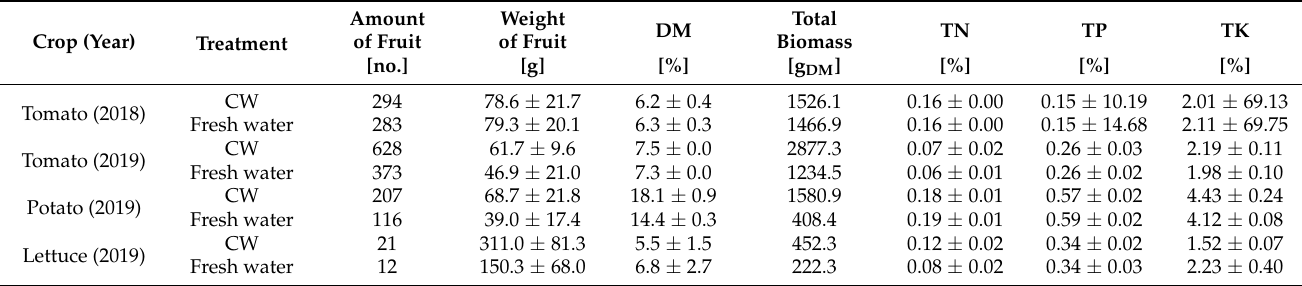
Table 6. Harvesting data from the irrigation field experiment.